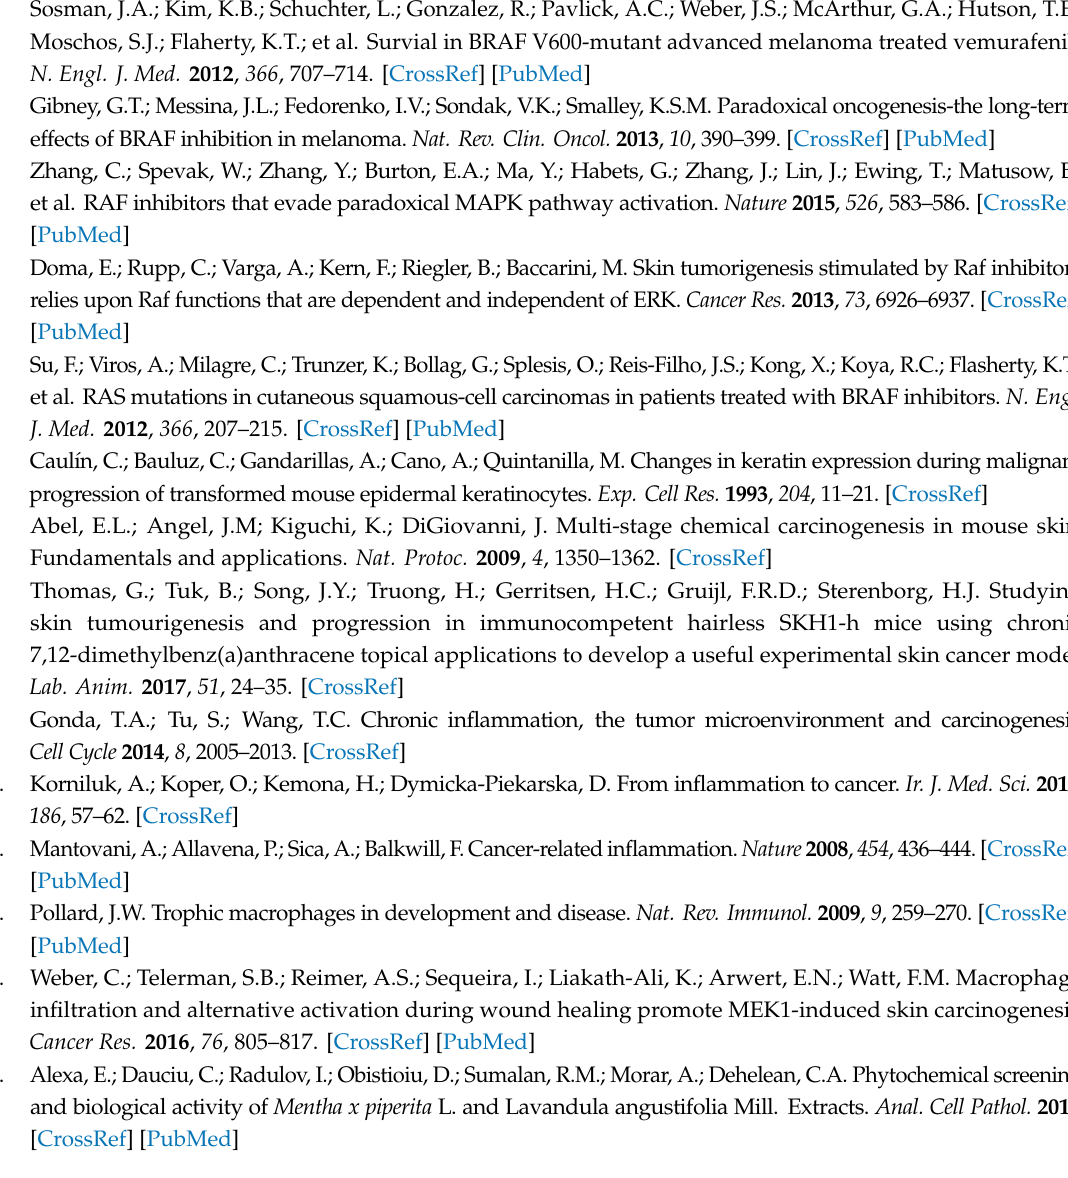
Supplementary Materials Figure 1: The experimental design of two-stage skin carcinogenesis mouse model, Supplementary Materials Figure 2: Mouse body weights recorded every